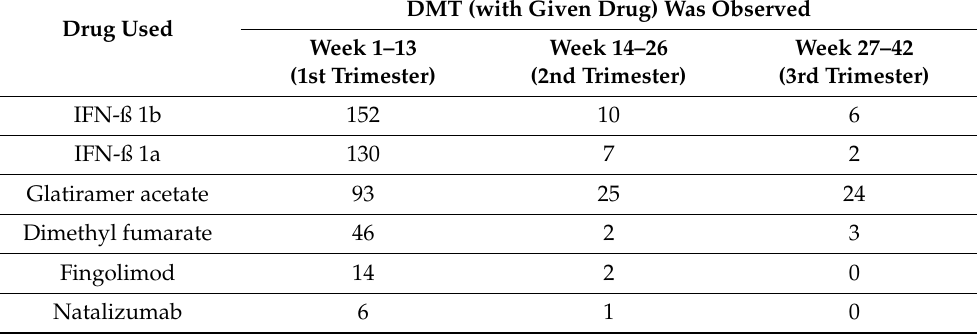
Table 5. Participation of pregnant MS patients in the DMT by type of